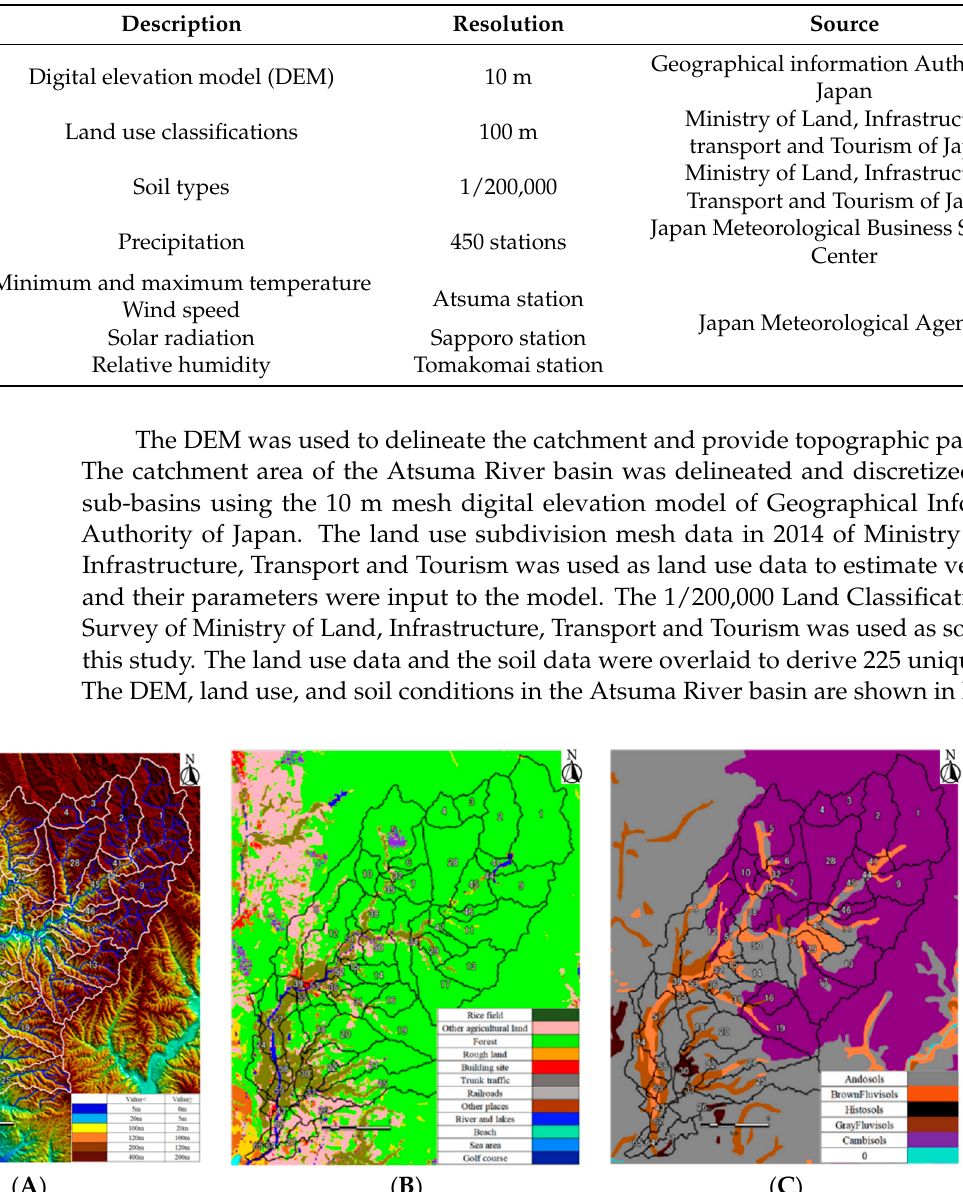
Table 1. The SWAT model input data for the Atsuma River basin.